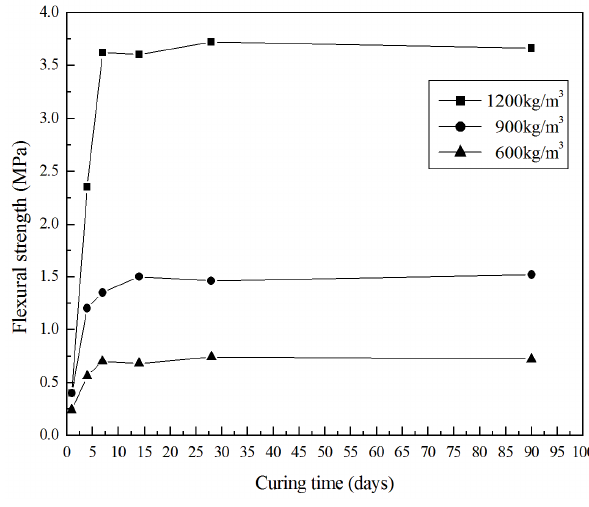
Figure 7. Flexural strength of GLWC vs. curing time.